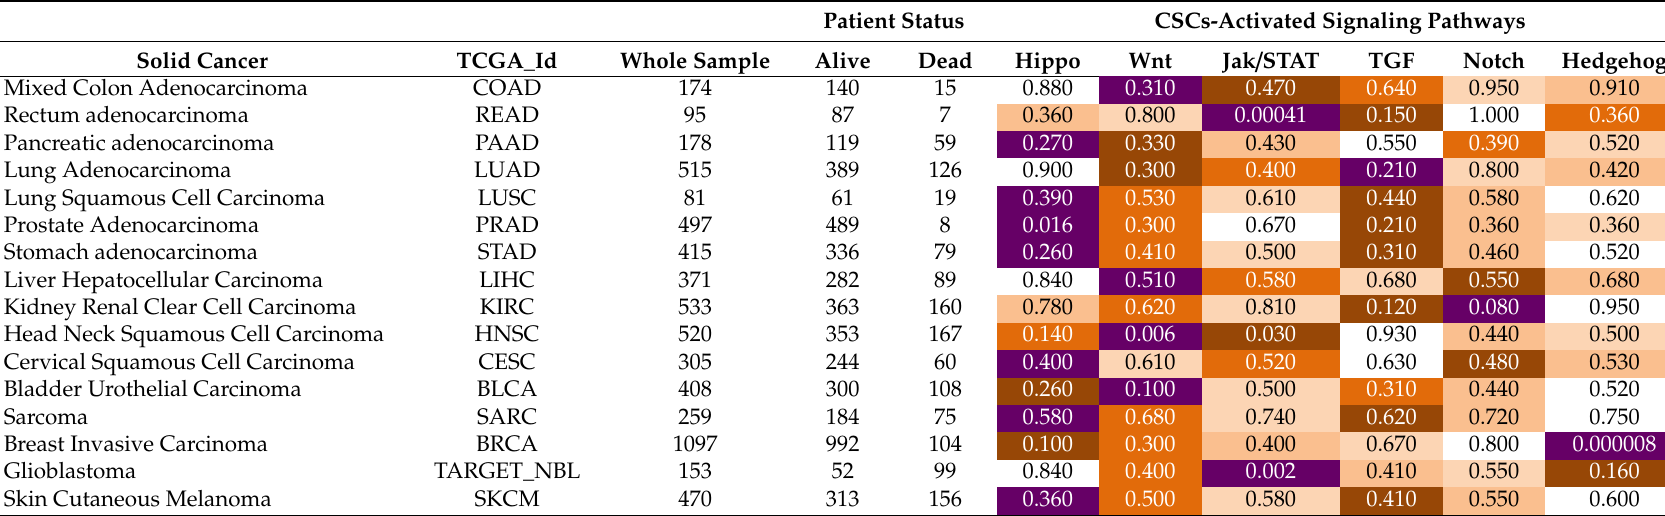
Table 1. Prevalence of CSCs-activated signaling pathways in solid tumors accordingly with outcome: Results obtained by R2 on line tool. Clustering the patients in dead and alive for each solid cancer, the values are indicative of how enriched in dead patients are the Hippo, Wnt, Jak / STAT, TGFb, Notch, Hedgehog pathways, based on gene expression data. The values are between 0 and 1 where 0 is the best over-representation. The color scale (from violet to white) groups the 6 CSCs pathways from the highest to the lowest enriched, among each TCGA (The Cancer Genome Atlas)